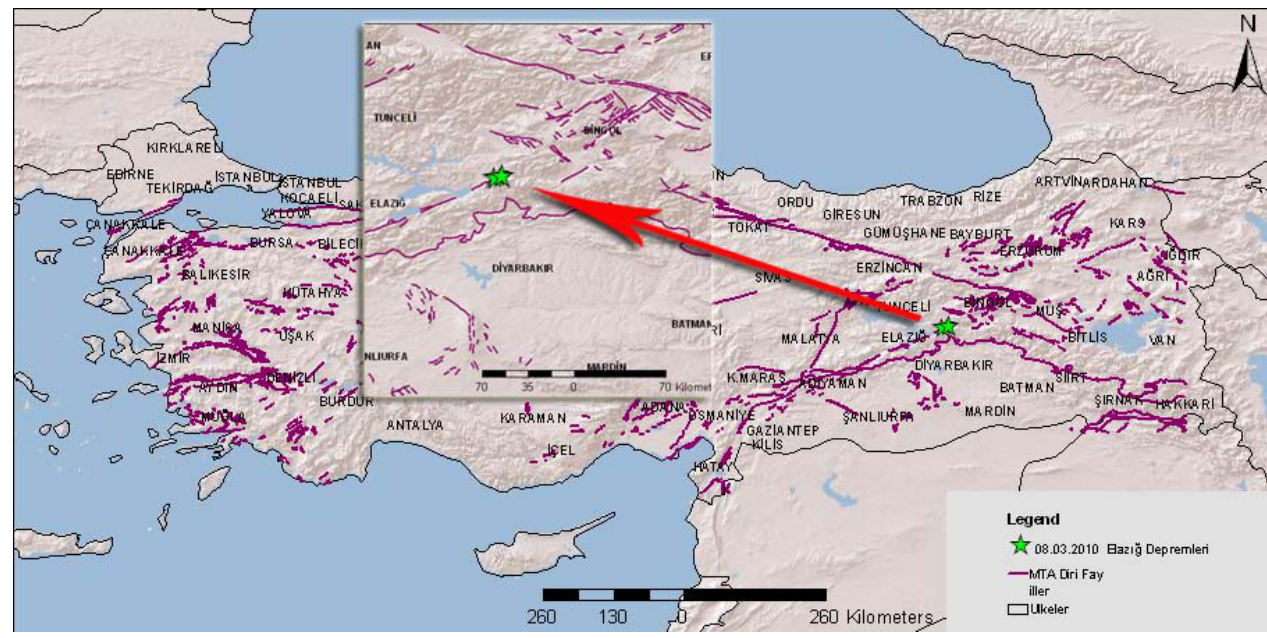
Fig. 1. Karakocan-Elazig earthquake (ED, 2010).